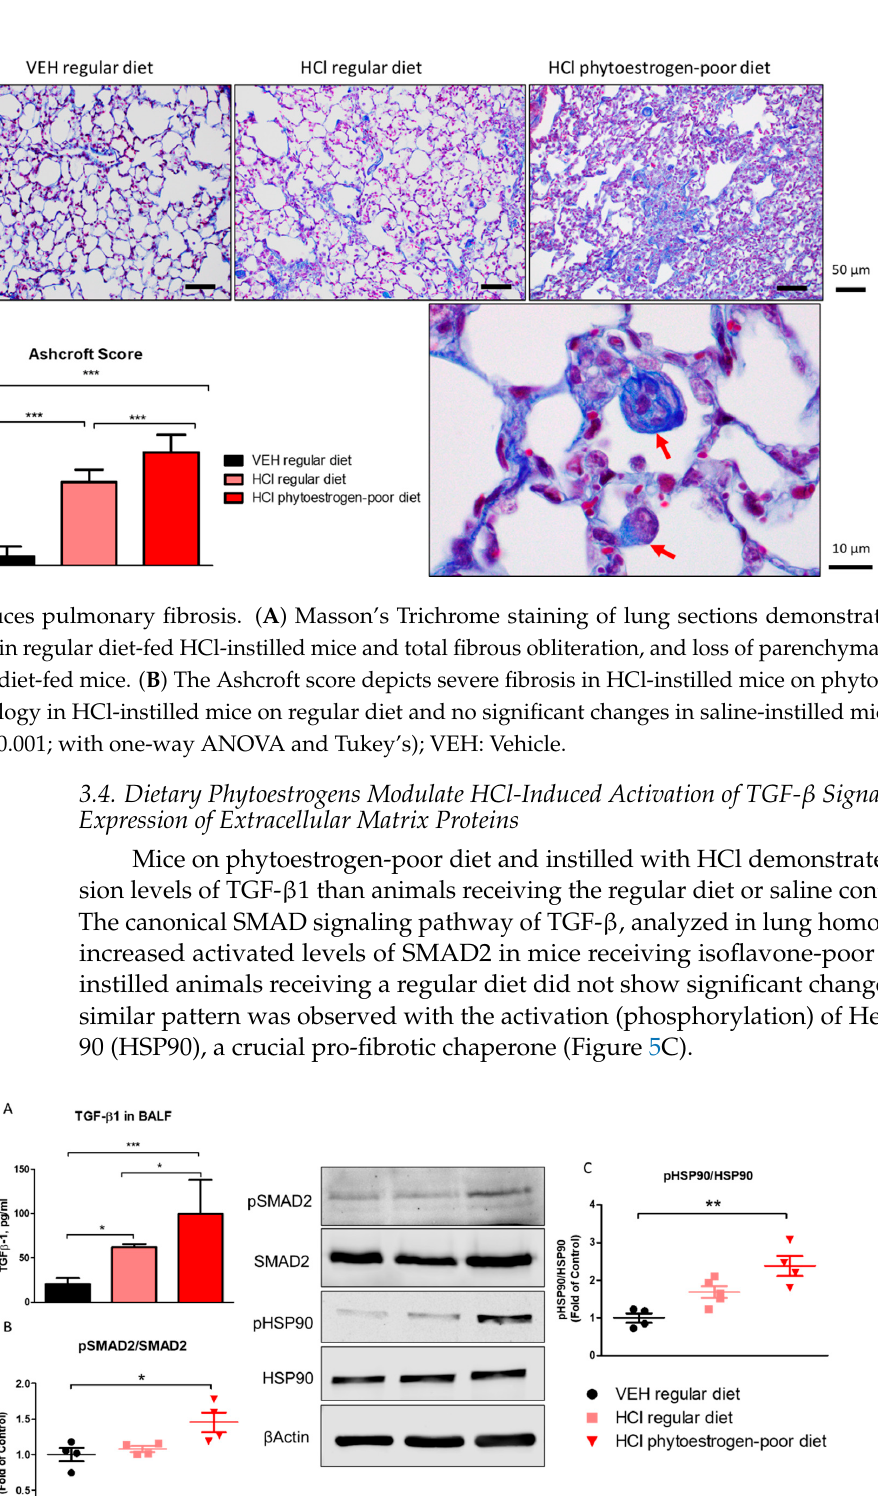
Figure 5. TGF- β levels and activation of intracellular pathways of TGF- β 30 days after HCl instillation. ( A ) Mice treated with HCl displayed increased expression levels of TGF- β 1 in bronchoalveolar lavage fluid (BALF) compared to saline. The levels of TGF- β 1 in mice on phytoestrogen-poor diet is significantly higher compared to mice on regular diet. ( B ) Active (phosphorylated) SMAD2 was significantly increased in mice on isoflavone-poor diet but not in animals on regular diet. ( C ) Heat Shock Protein 90 activation (pHSP90) increased only in phytoestrogen-poor fed mice. Means ± SEM; ***: p < 0.001, **: p < 0.01, *: p < 0.05 with one-way ANOVA and Tukey’s, n = 8–9 ( A ), n = 4–5 ( B , C ); VEH: